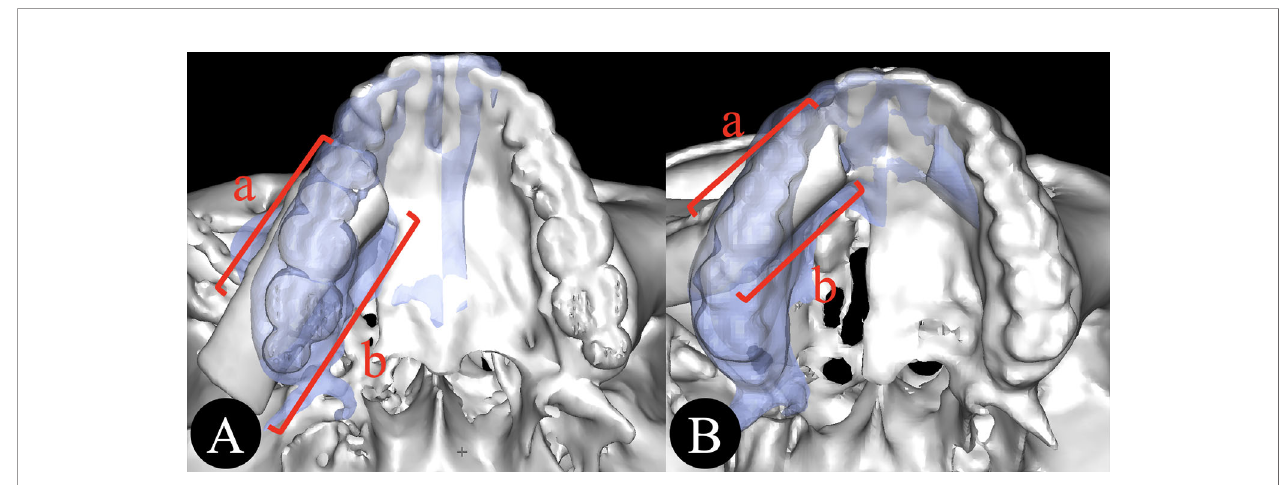
FIGURE 2 | (A, B) Dental arch reconstruction rate. DAR = a/b (a, the length of the iliac bone overlapping the dental arch; b, the total length of iliac bone segments for alveolar